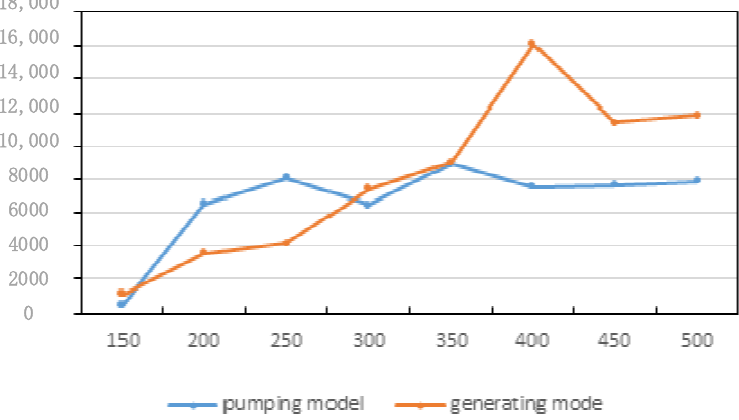
Figure 4. Comparison of PHES output with different capacities.